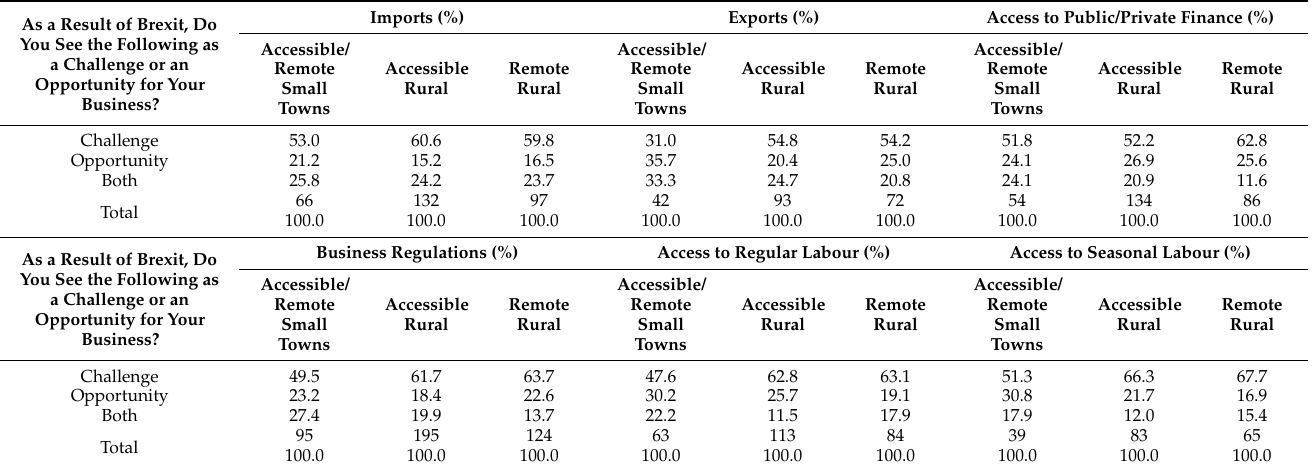
Table 7. Comparative analysis of challenges related to Brexit between rural non-land-based businesses in different rural classifications that have a relationship with the farming sector in